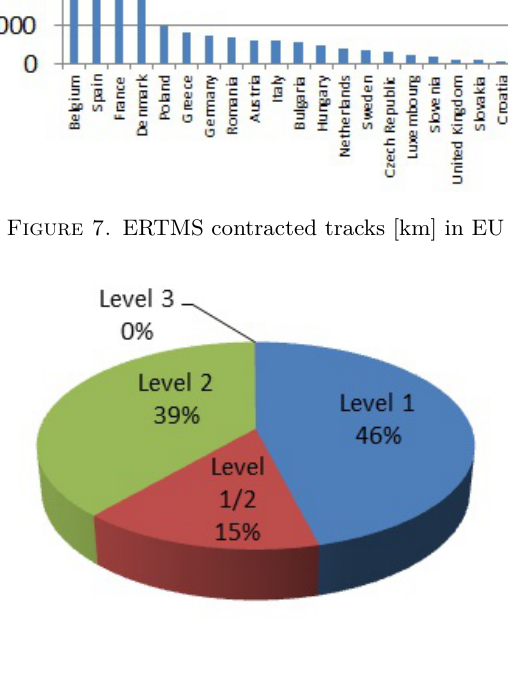
Figure 10. Vehicles in EU separated by